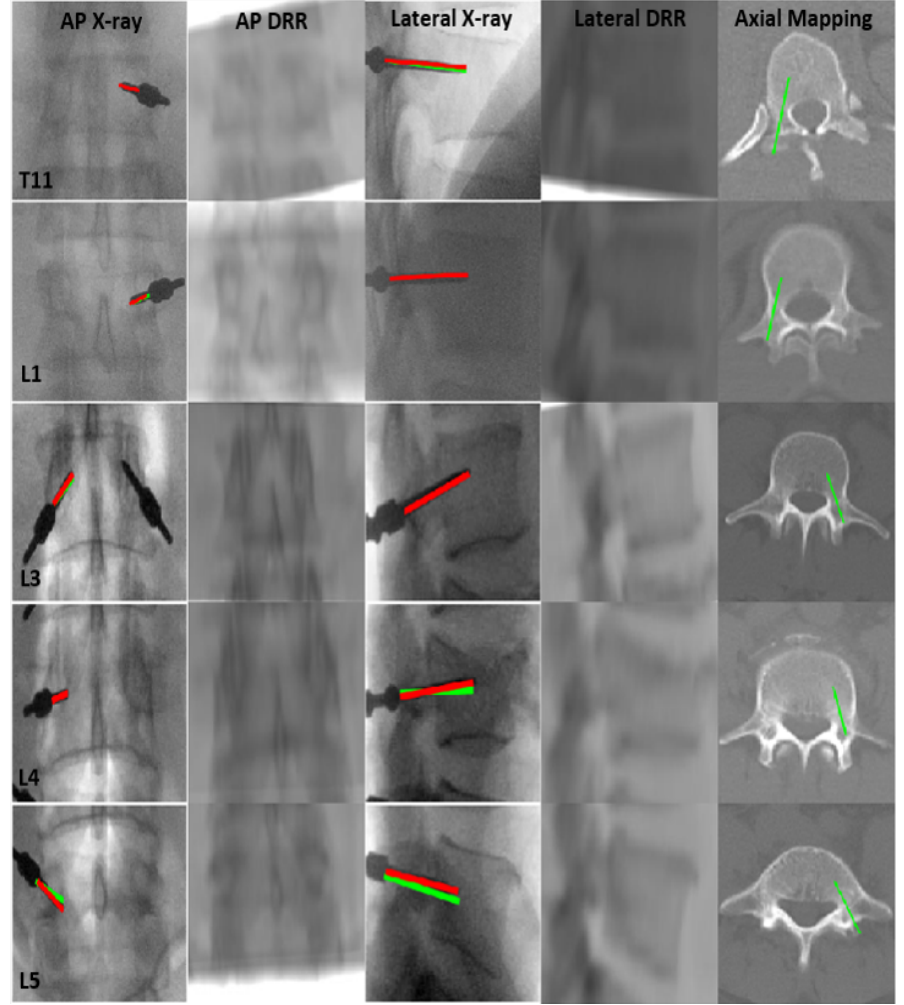
Figure 6. Clinical validation of pedicle screw trajectory registration: Red and Green lines in Columns 1 and 3 are the center axis of true and reprojected trajectories displayed on AP and lateral radiographs, respectively. Columns 2 and 4 display DRR images generated at the optimal anatomical landmark registration point in the AP and lateral planes, respectively. Column 5 displays axial trajectory mapping on pCT at optimum registration point of different vertebral levels—Source: Orthopaedics and Radiology Department—KMC